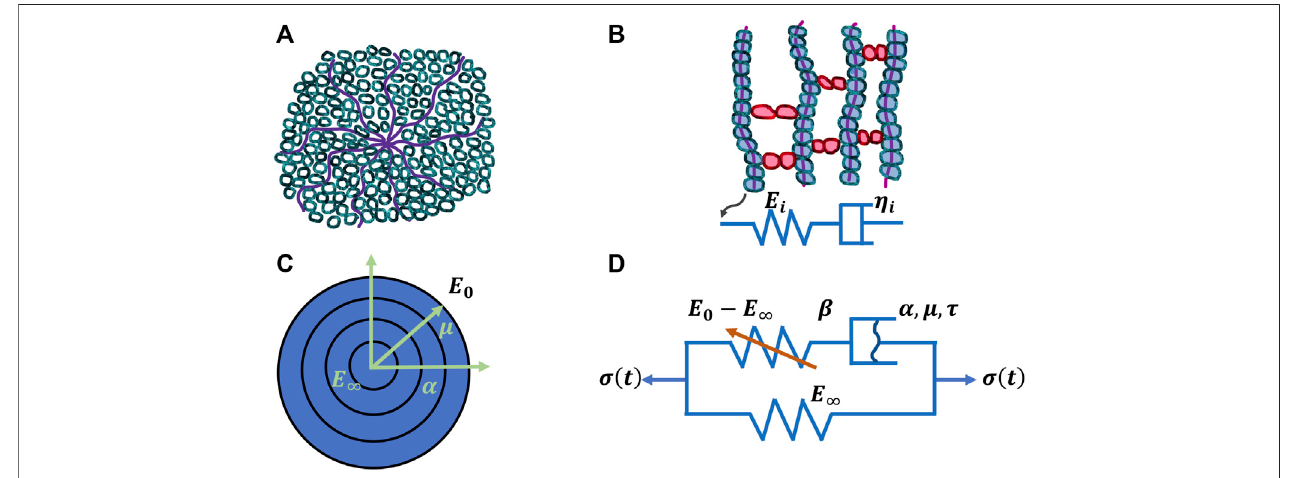
FIGURE 3 | Four models for viscoelasticity. (A) Classical arm-retraction model, (B) Classical Prony series model, (C) New model and (D) Nonlinear spring- dashpot model.